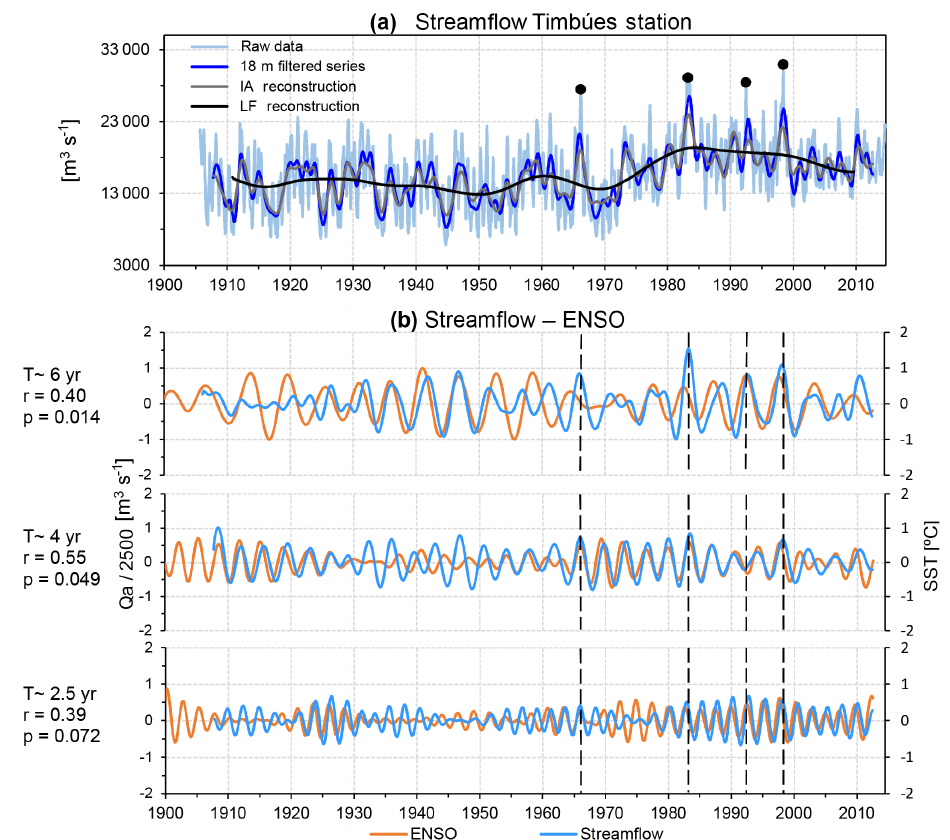
Figure 4. (a) Monthly mean streamflow time series for the Paraná River at Timbúes station and its partial reconstruction using all significant modes of interannual (IA reconstruction) and decadal-to-multidecadal variability (LF reconstruction) presented in Table 2. (b) Time series of the dominant modes of Paraná River streamflow anomalies and the ENSO pattern on interannual timescales. Streamflow modes have been scaled to facilitate their interpretation. Dominant periods ( T ) of the leading modes and Pearson correlation coefficients ( r ) together with their significance levels ( p ) are given to the left of the figure. Significance levels ( p values) for r are estimated by combining 2000 Monte Carlo iterations considering autocorrelation by resampling in the frequency domain (Macias-Fauria et al., 2012). Vertical dashed lines coincide with extreme flood events in 1966, 1983, 1992 and